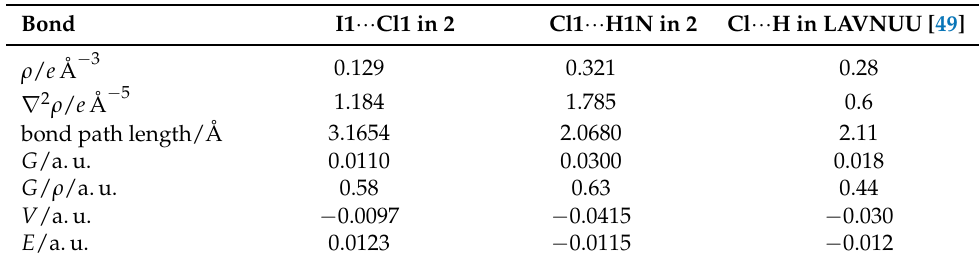
Figure 8. Atomic basins [47,48] in 2 ; intramolecular bond paths and the conventional hydrogen bond are shown as solid black lines, the halogen bond and non-classical hydrogen bonds as dashed black lines. Table 2. Short contacts with properties of their bond critical point (bcp) ( 3, − 1 ) in 2 and experimental data from LAVNUU